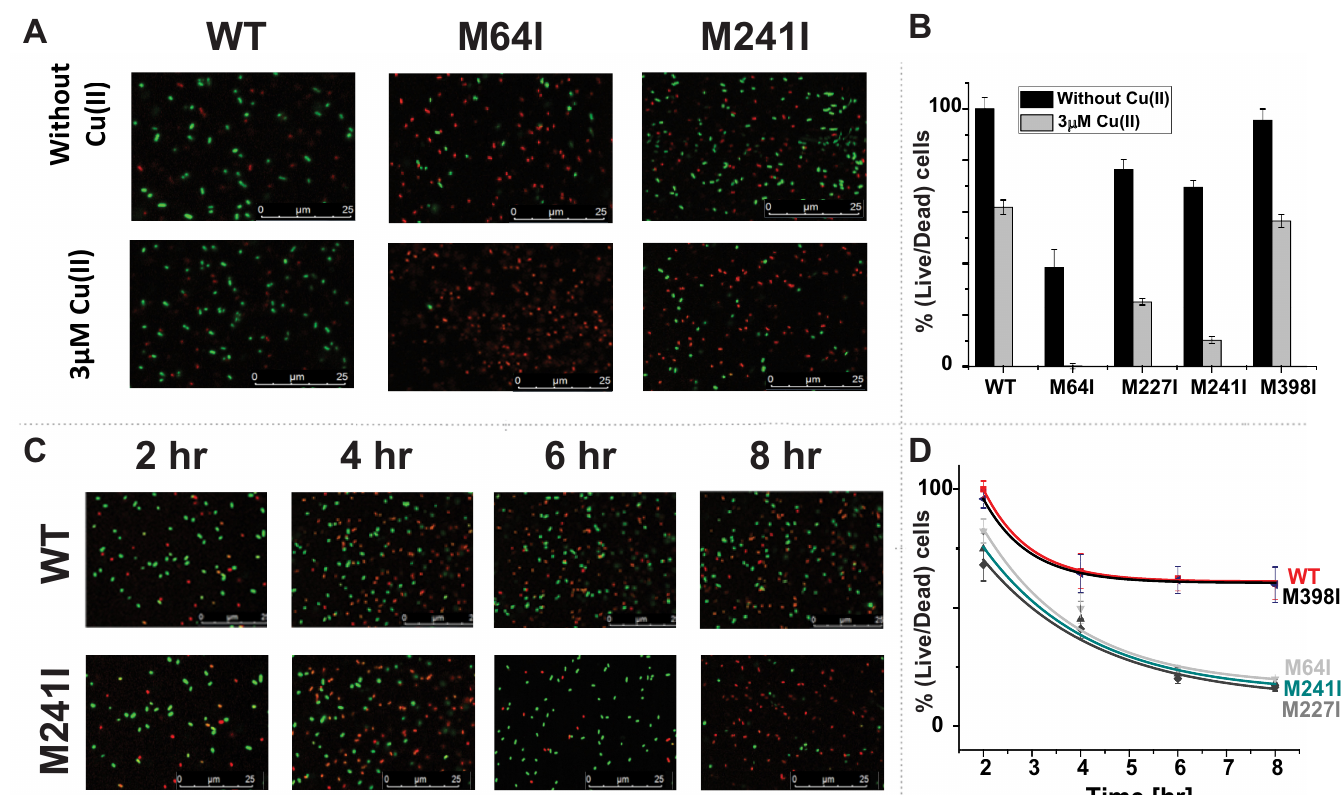
Fig 5. Cell viability imaging. A. Cell viability imaging for WT-CusB, CusB_M64I, and CusB_M241I; cells were grown with and without Cu(II) at the late lag phase (3–4 hr). Green dots denote live cells; red dots denote dead cells. B. Cell viability comparison at the late lag phase for all CusB clones in the presence and absence of Cu(II). C. Cell viability imaging for WT-CusB and M241I grown with Cu(II) as a function of time. Green dots denote live cells; red dots denote dead cells. D. Cell viability comparison for all CusB clones in the presence of Cu(II) as a function of time.